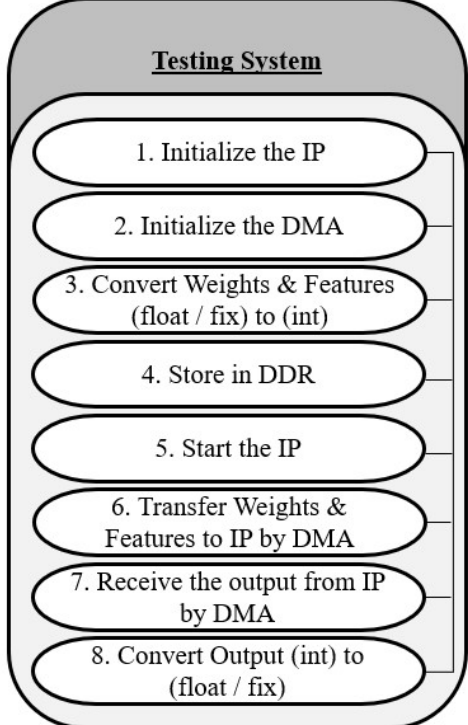
Figure 9. SDK test for DDR architecture.